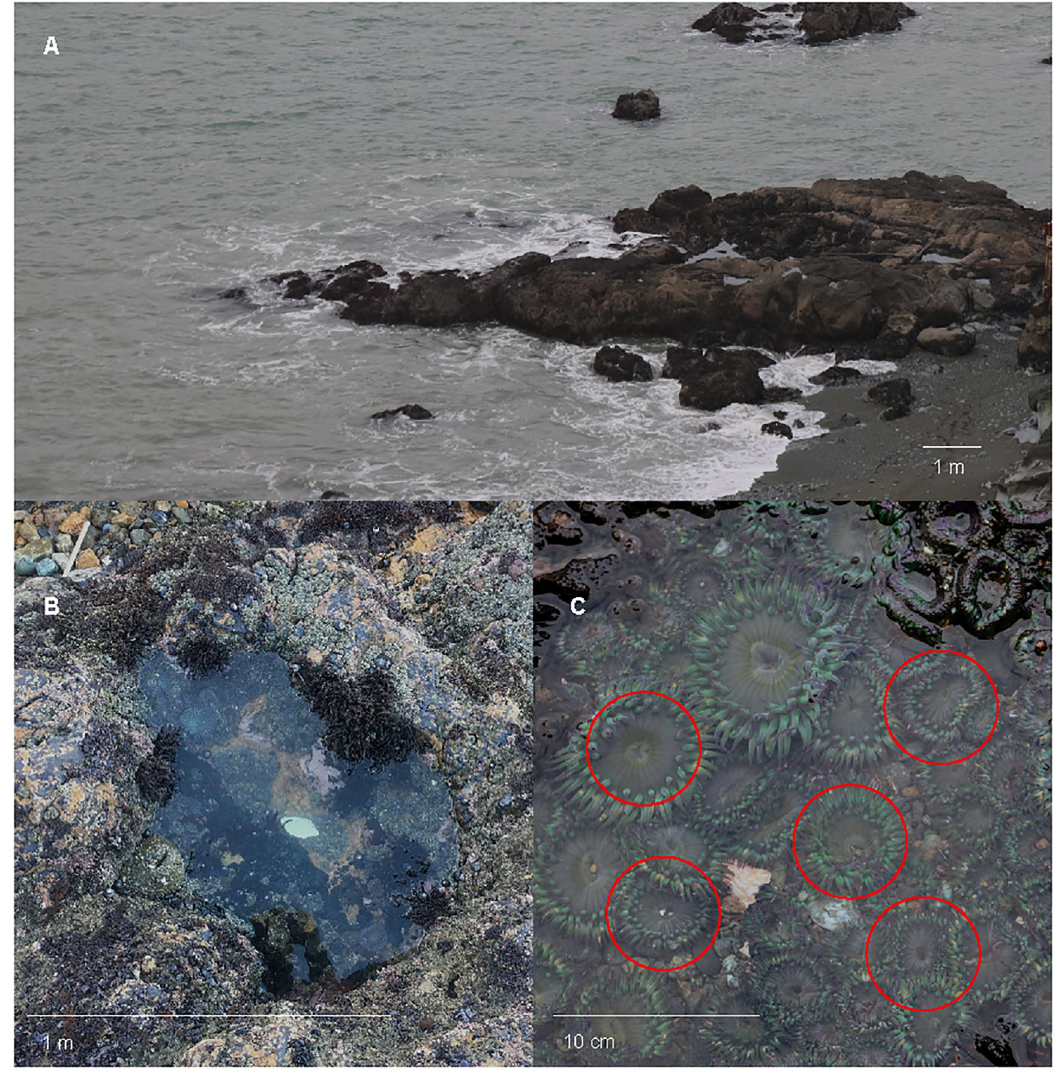
Fig 2. Example of sampling regime in three pools at a single site. Three pools per site were chosen based on colony presence and tidal height of each pool. Five anemones within pools were randomly selected (circled in red) and sampled for tentacles (3–4 per anemone) to assess symbiont density change over time. A) Example of vertical height change across survey pools at Point Bonita B) Pool at Point Bonita with a single colony C) Close up view of an A . elegantissima colony.